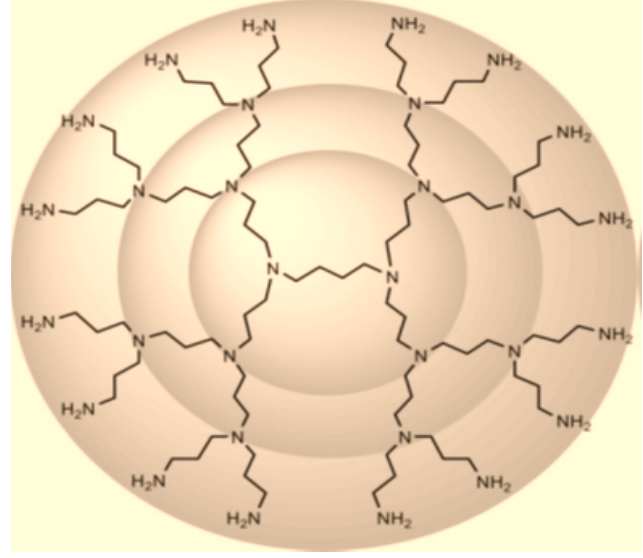
Figure 3. POPAM dendrimer of generations G n with two growth stages, POD 2 r 2 s . Table 3. Edge partition of POPAM dendrimer, POD 2 r n s based on degree sum of neighbors of end vertices of each edge.